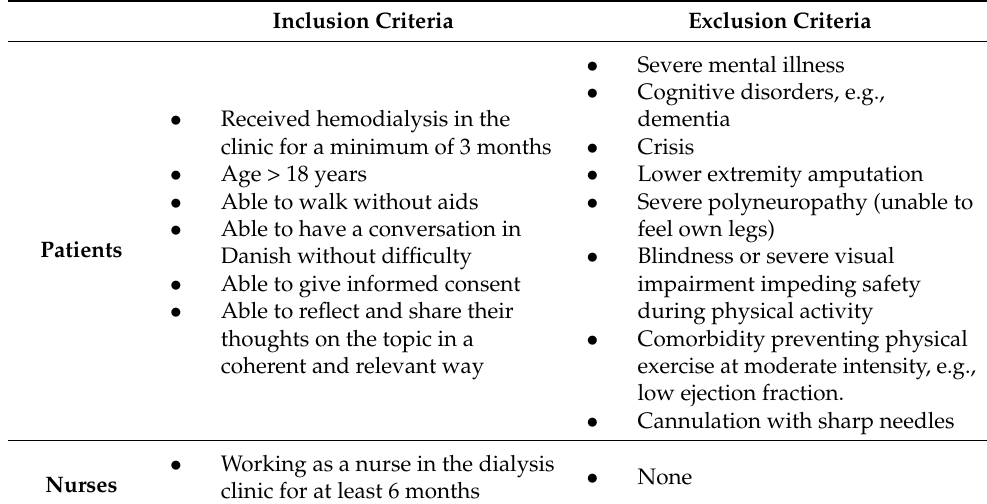
Table 1. Inclusion and exclusion criteria for patients and